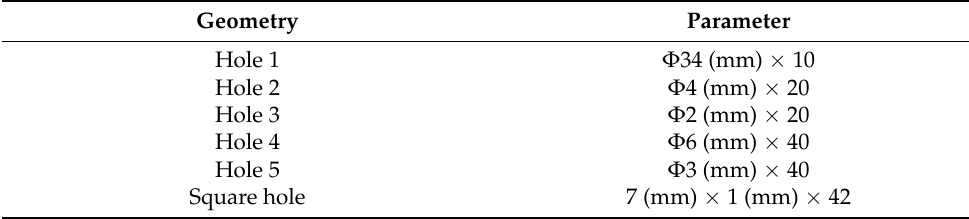
Table 1. Geometrical parameters of the holes in the casing.